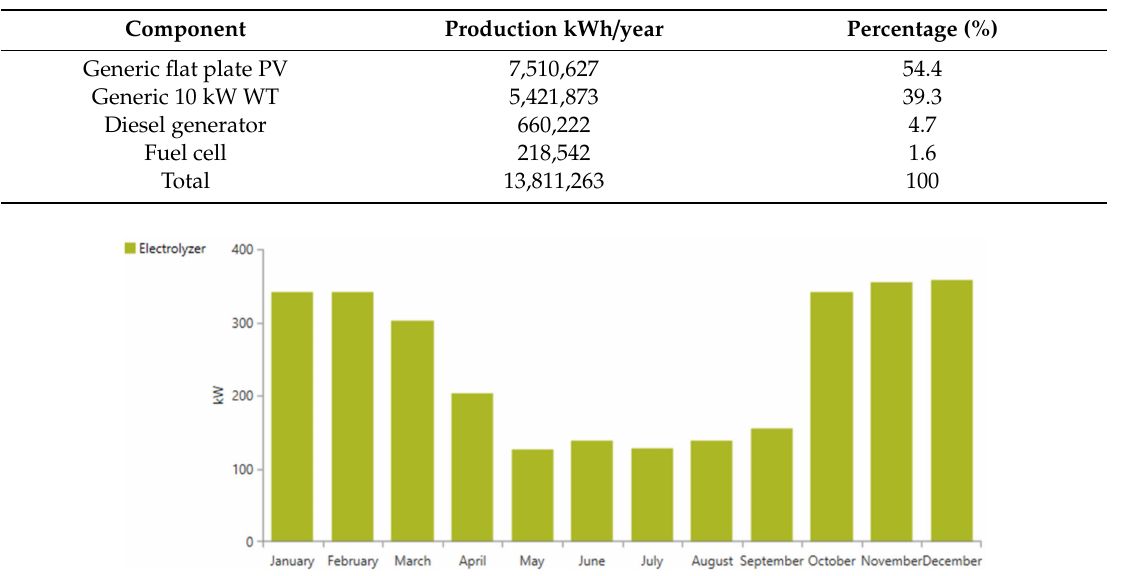
Table 4. Electrical production.